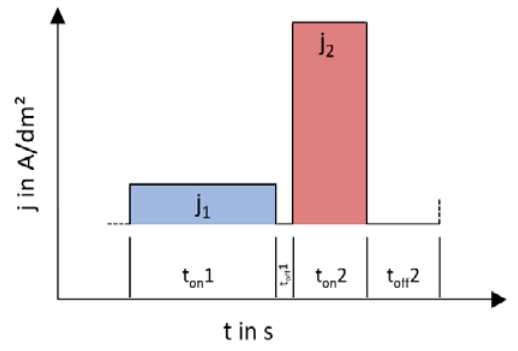
Figure 3. The used pulsed-like current regime.